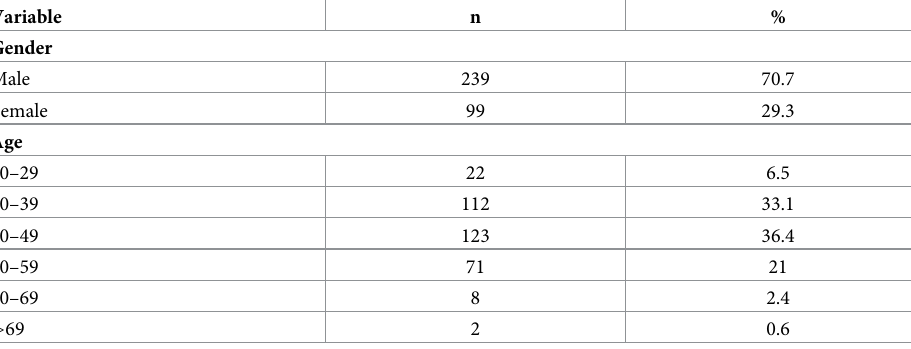
Table 1. Gender and age distribution (n =